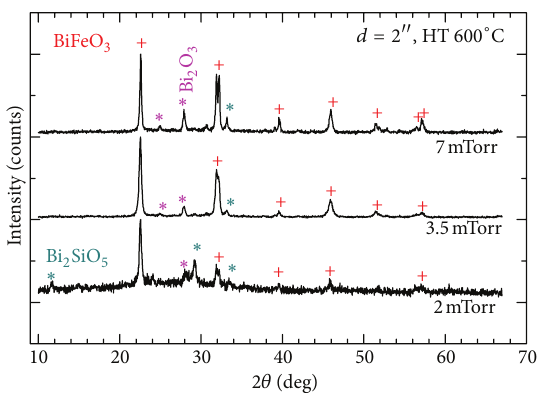
Figure 2: Grazing incidence XRD patterns of BFO films measured under different incidence angles. BiFeO 3 peaks are indicated by crosses, those of Bi 2 SiO 5 by lines, and those of Bi 2 O 3 by stars.